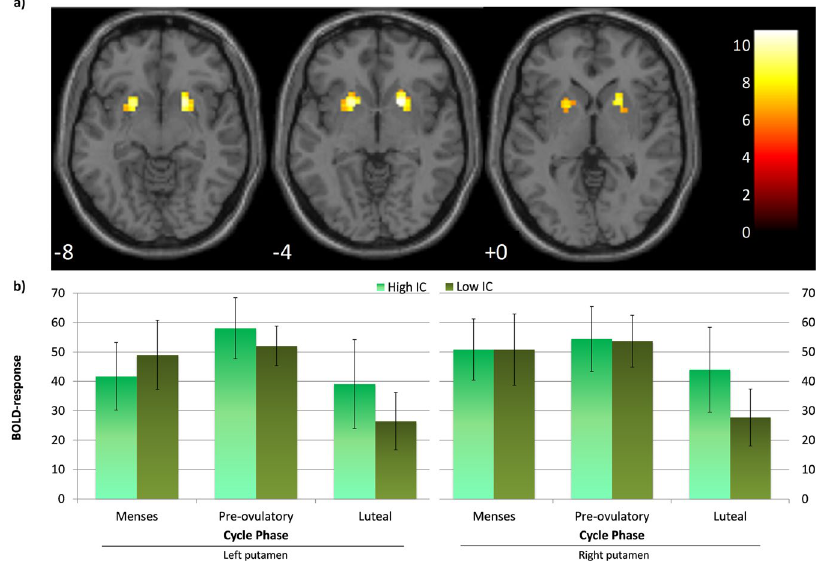
Figure 3. ( a ) Seed region for region of interest (ROI) and psychophysiological interaction (PPI) analysis: Bilateral putamen, peak coordinates [ − 18, 8, − 5], [21, 11, − 5]. ( b ) BOLD-response in the left and right putamen across the menstrual cycle: the BOLD-response significantly decreased during the luteal phase compared to the pre-ovulatory phase, irrespective of the baseline inhibitory control (IC). Baseline IC as a covariate of interest was used as a continuous variable, but the sample is split by the median for displaying purposes. Error bars represent standard errors.